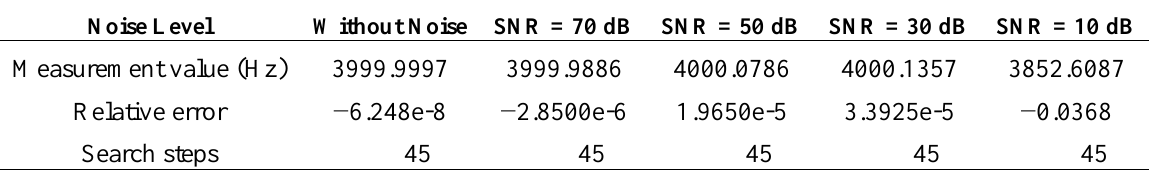
Table 3. Measurement results statistics of the search method under different level